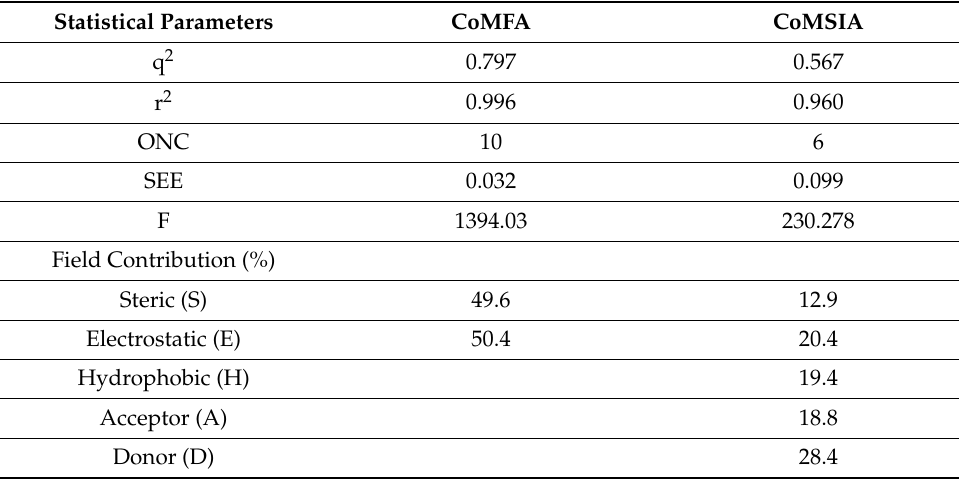
Table 1. The best results of the CoMFA and CoMSIA PLS statistical